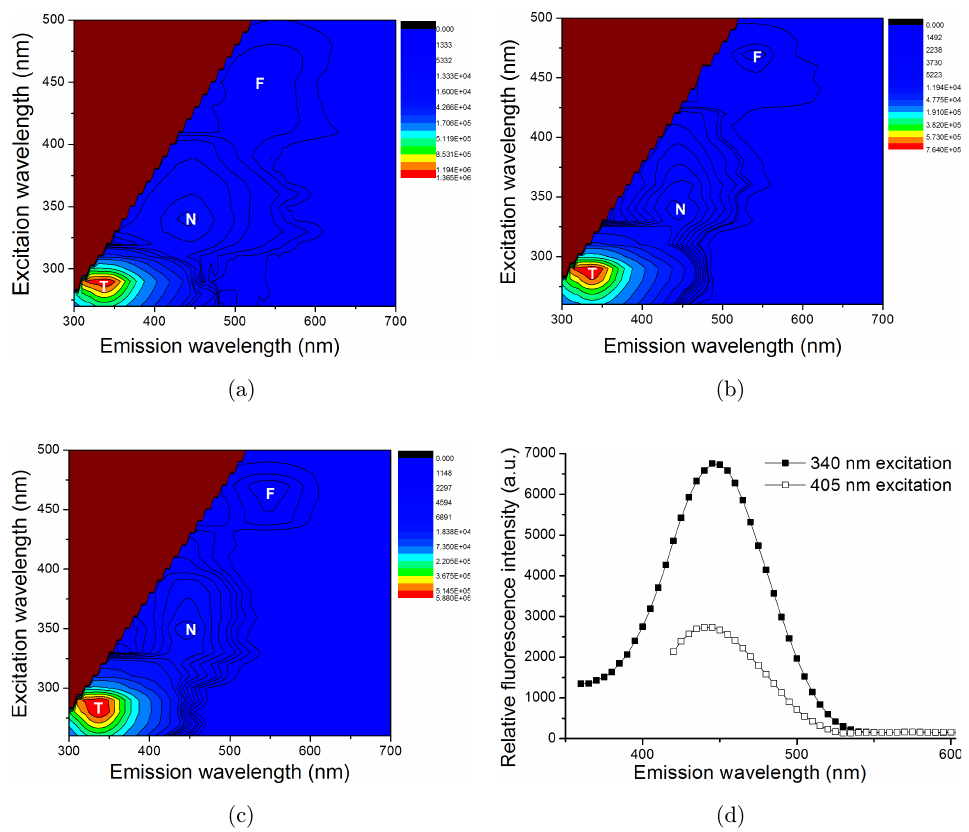
Fig. 1. Auto°uorescence EEMs of (a) K562, (b) HL60 cells, (c) MNC and (d) two examples of the special cases ( (cid:4) ex ¼ 340 and 405 nm) from MNC. Auto°uorescence peaks \T", \N", and \F" are attributed to tryptophan, NAD(P)H, and FAD,